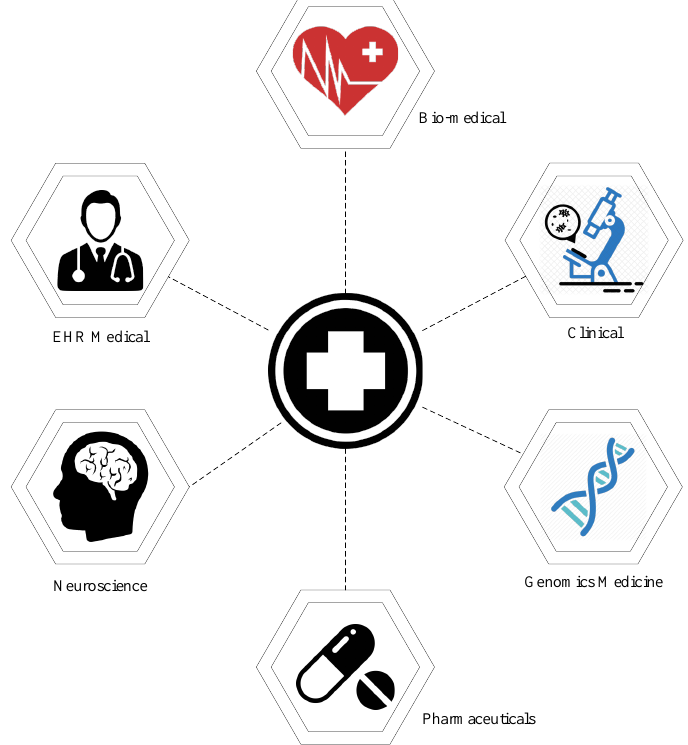
Figure 1. Applications of blockchain in